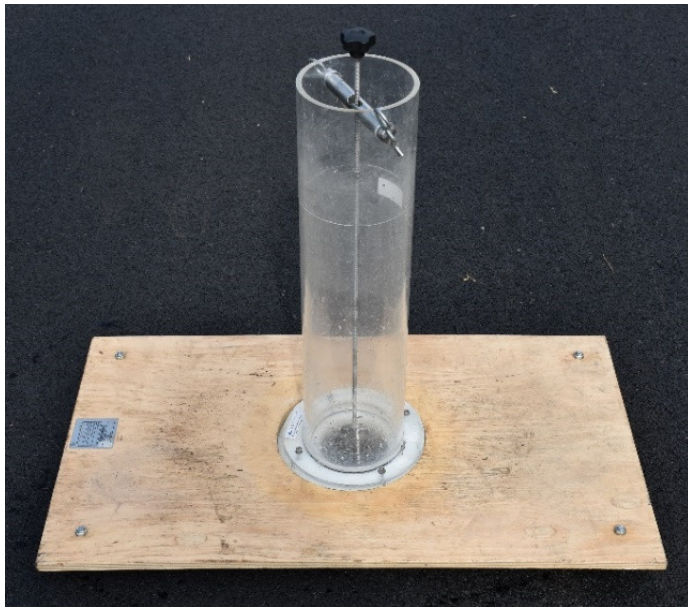
Figure 5. Water drainability testing device for the in situ method.